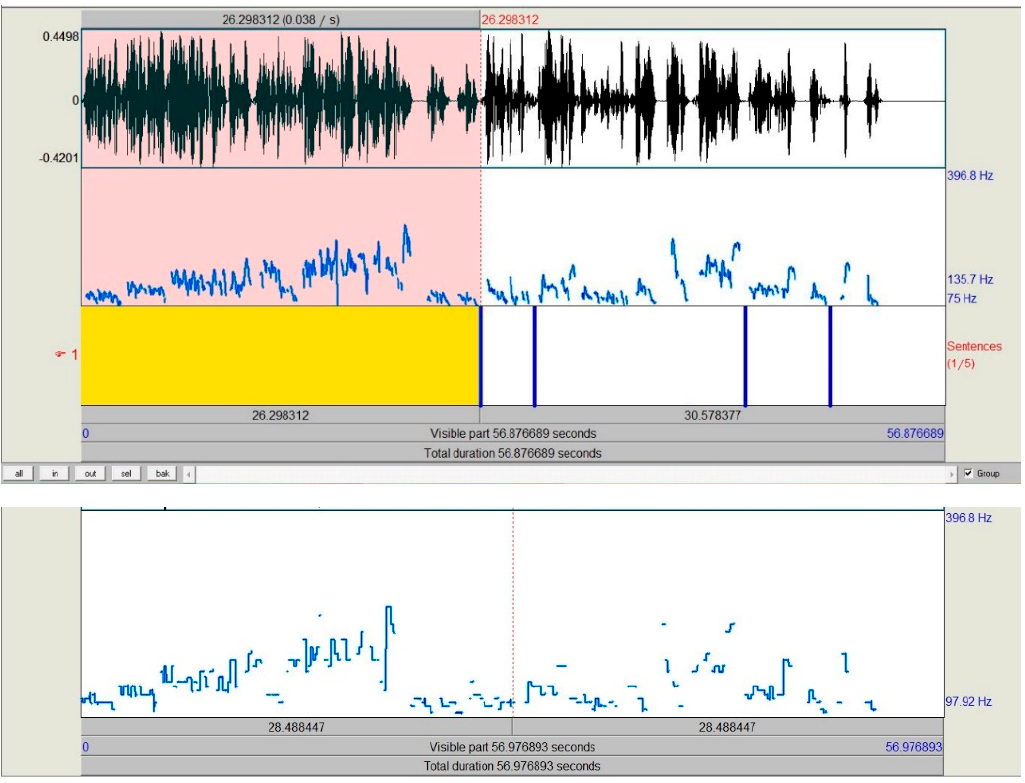
Figure A3. Stimulus 3—Pitch structure. Figure A4. Stimulus 3—Pitch structure. Table A3. Stimulus Table A3. Stimulus 3—Transcription.